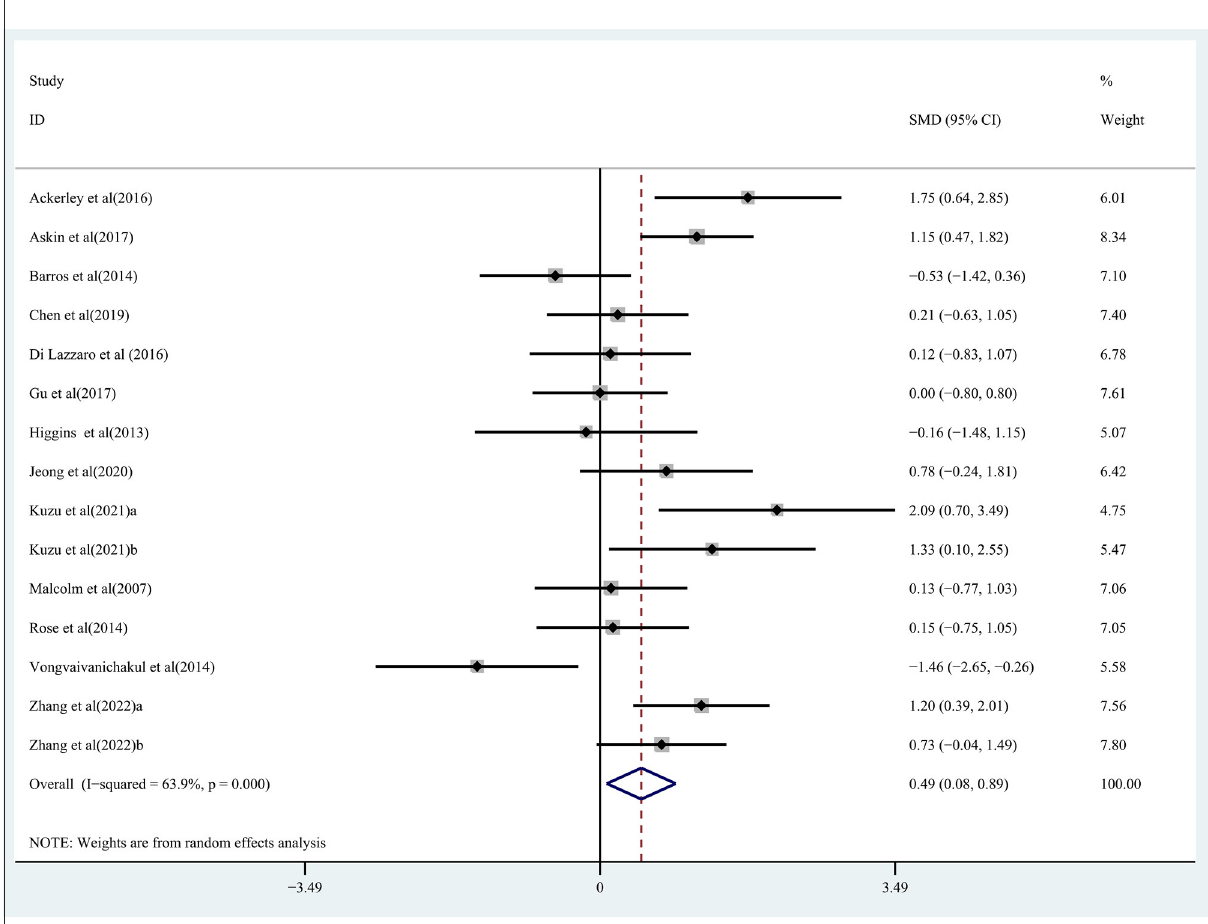
FIGURE2 Forest plot of the effect of rTMS treatment on upper extremity function recovery in chronic stroke